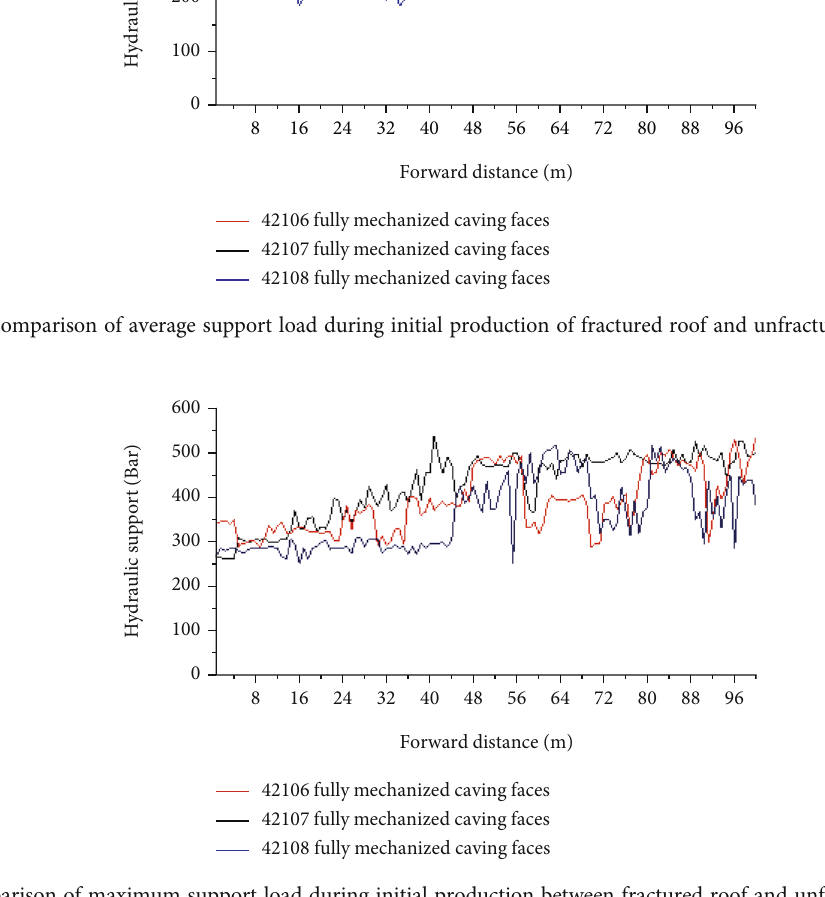
Figure 9: Comparison of maximum support load during initial production between fractured roof and unfractured working face.